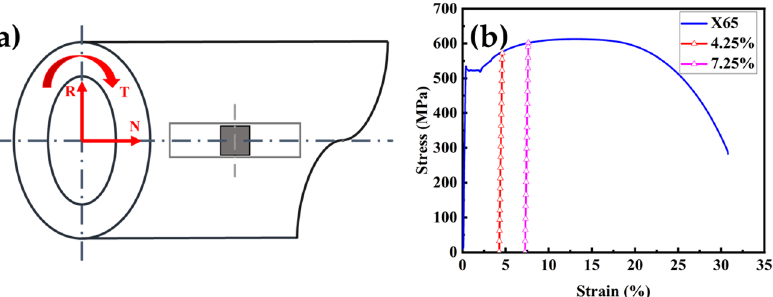
Figure 2. ( a ) Hydrogen permeation specimen sampling diagram, ( b ) engineering strain curves in the cold deformation loaded–unloaded condition. cold deformation loaded–unloaded